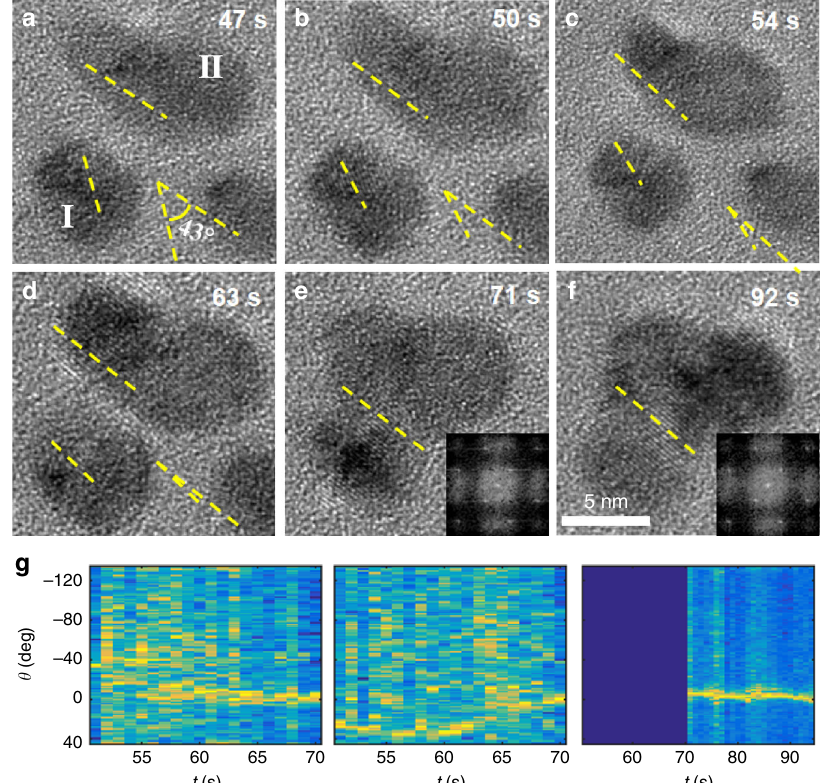
Fig. 2 Oriented attachment of ZnO nanoparticles. a – f Sequence of LP-TEM images showing OA of ZnO nanoparticles in methanol solution containing 1 mM Zn 2 + . Scale bar is 5 nm. g 1D intensity pro fi les versus time created from FFT analyses (particle I: left panel, particle II: middle, fused particle: right) of image sequence show that the two particles rotated and aligned their crystallographic axes within 20 s prior to contact. This result is manifest as a trace of high contrast (yellow) in the panels of g